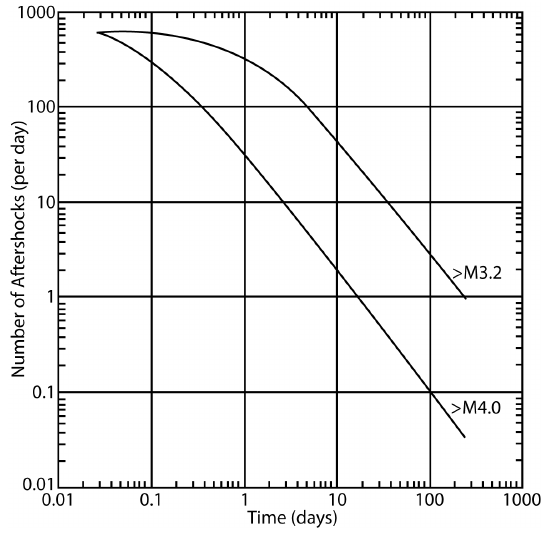
Fig. 6. Possible aftershock decay model following a M w = 8 . 0 earthquake. From Utsu et al. (1995).